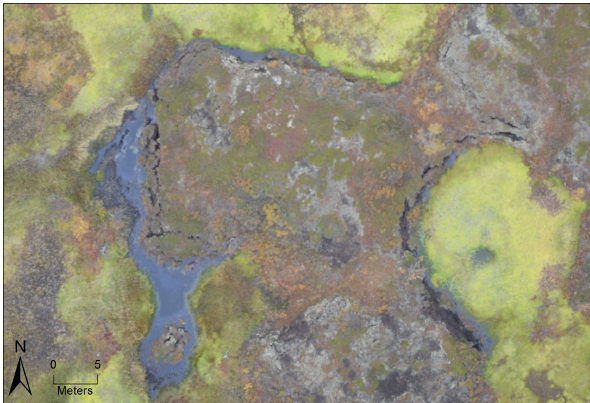
Figure 13. High-resolution aerial image of a peat plateau in mire 7 at Suossjavri. Note the ongoing block erosion at the margins where blocks of peat collapse in the thermokarst ponds flanking the erod- ing edge. The more stable margins do not feature ponds and mire vegetation grows directly at the edge of the peat